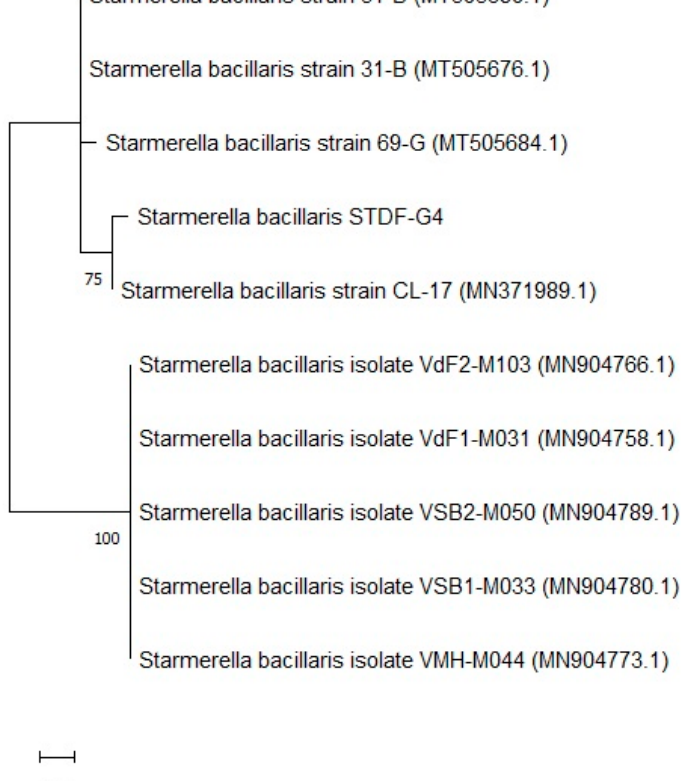
Figure 12. Phylogenetic tree of Starmerella bacillaris (STDF-G4) within the relative strains. The tree was constructed using the Maximum Likelihood tree method with bootstrap values for 500 replicates using the MEGA 11.0